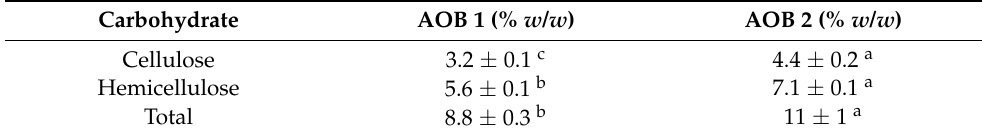
Table 2. Carbohydrate polymers in African oil bean (AOB) seeds. Carbohydrate